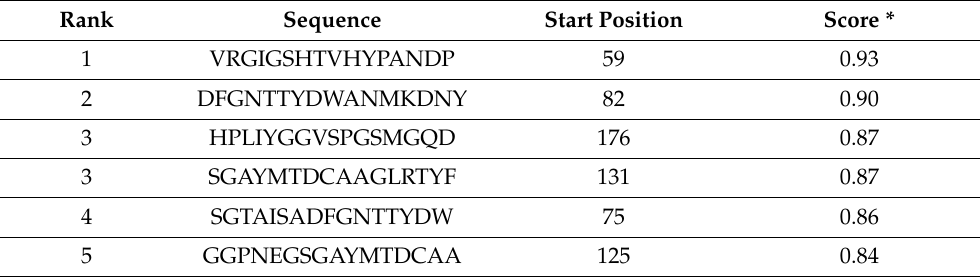
Table 3. Identification of B-cell epitopes